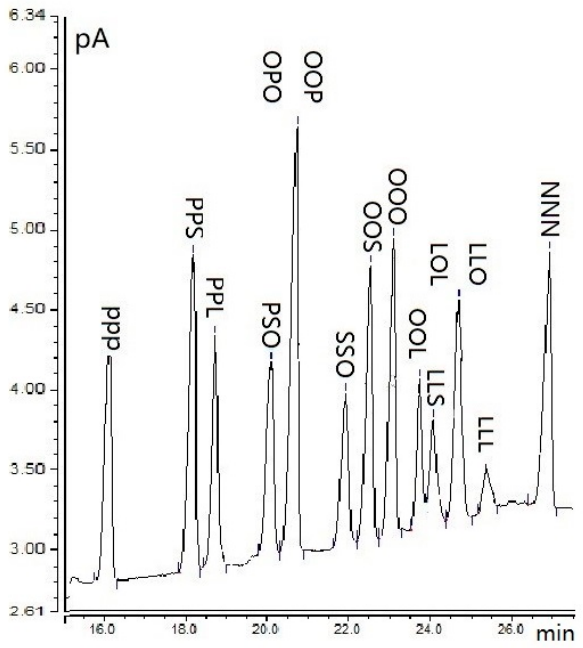
Figure 2. GC-FID chromatogram of triacylglycerols (TG) standards.